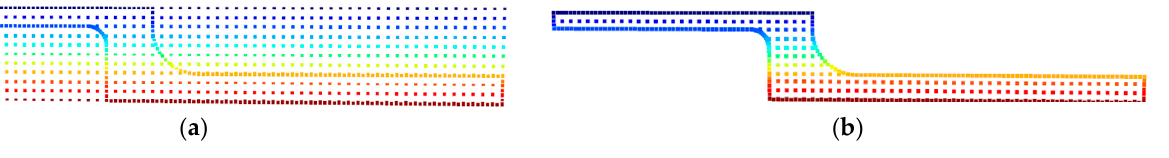
Figure 5. The procedure of plane point cloud trimming : ( a ) The point cloud of the plane before trimming; ( b ) The trimmed point cloud through the ray casting method.